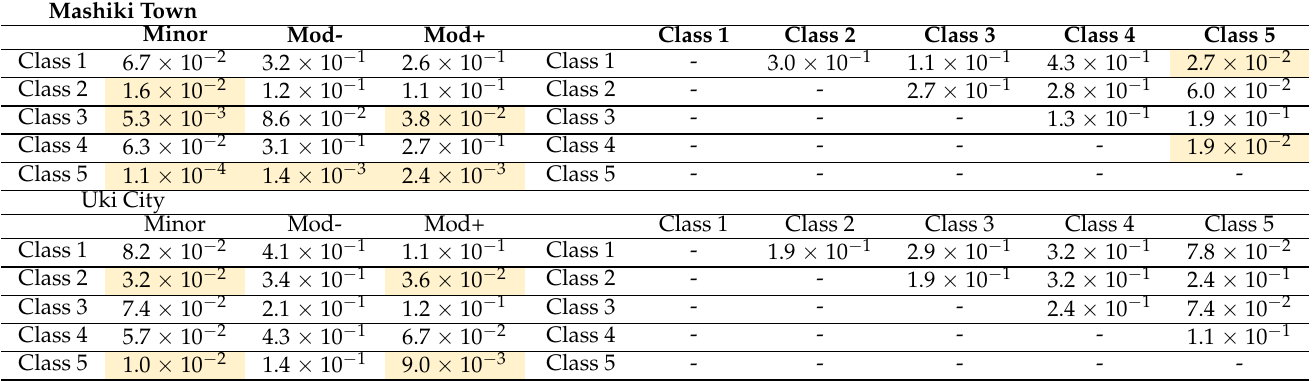
Table 3. Results of the significant difference test for R between the damage classes (yellow indicates a significant difference was